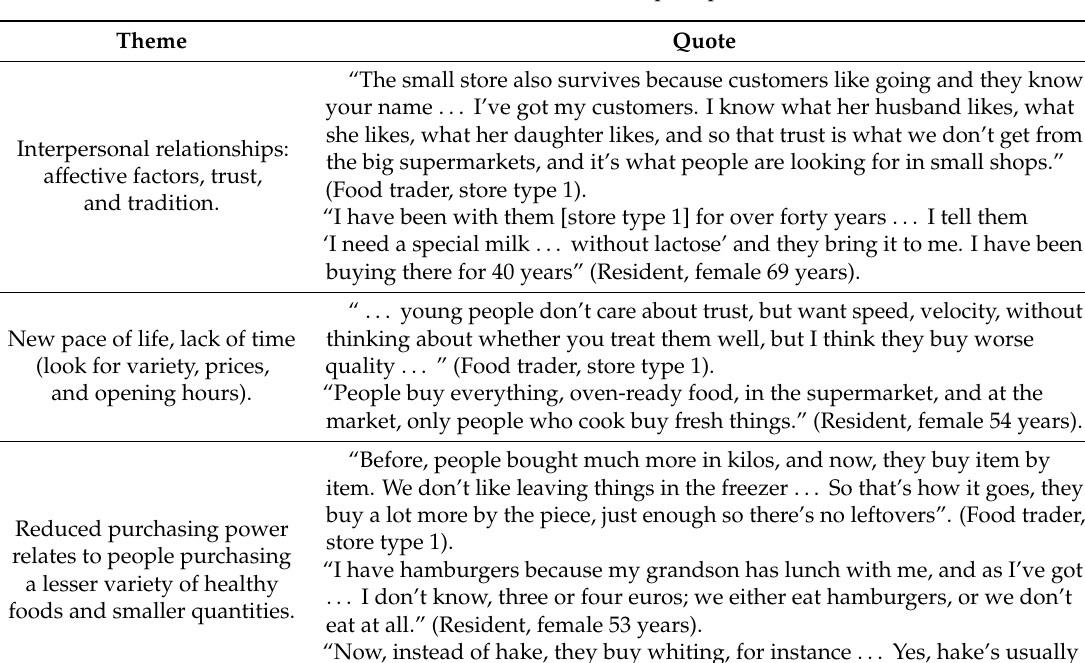
Table 3. Main results of residents’